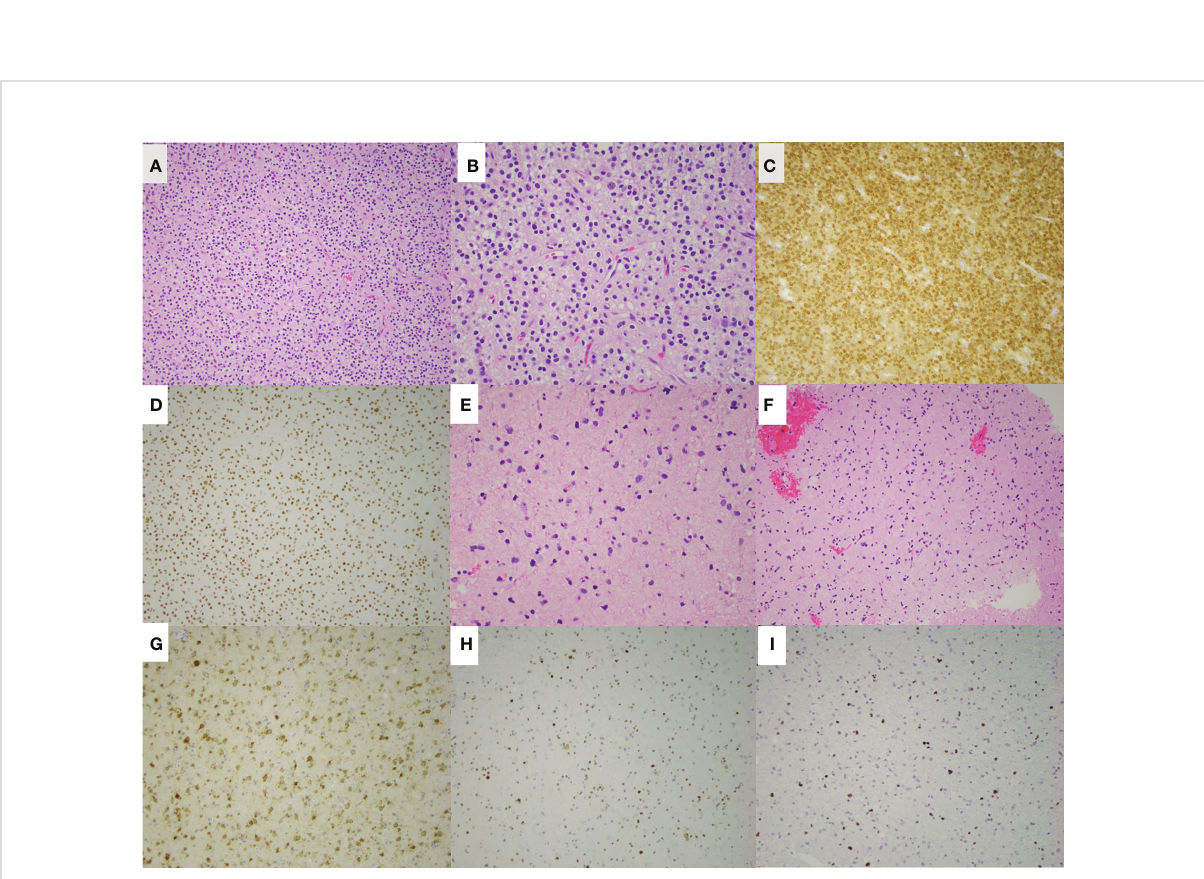
FIGURE 2 H&E staining of the left parietal oligodendroglioma in patient 1 is shown at low magni fi cation (A) and high magni fi cation (B) . Additional staining of the left parietal lesion shows IDH-1 (R132H) mutation (C) and ATRX retained (D) . H&E staining of the right frontal astrocytoma is shown at low magni fi cation (E) and high magni fi cation (F) . Additional staining shows IDH-1 (R132H) mutation (G) , ATRX loss (H) , and p53 overexpression (I) of the right frontal